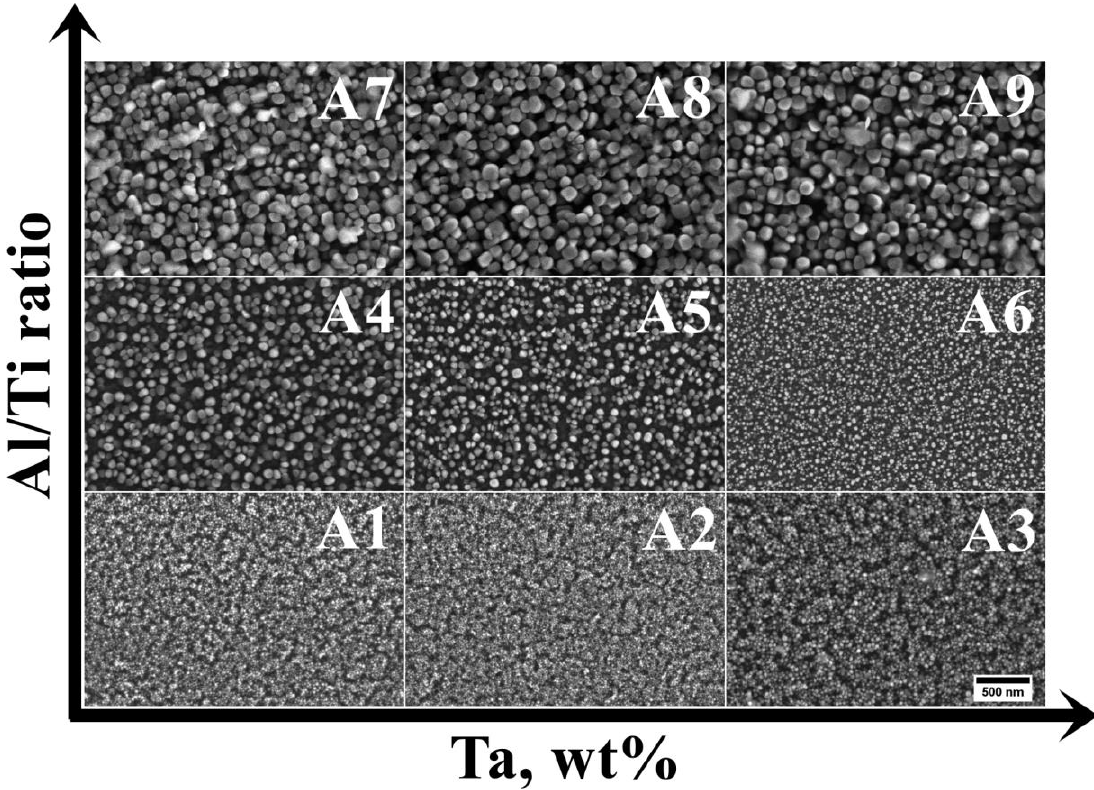
Figure 5. Precipitates in the dendritic regions of the (A1 – A9) castings, SEM-SE. Table 3. γ (cid:48) precipitates size in the dendritic